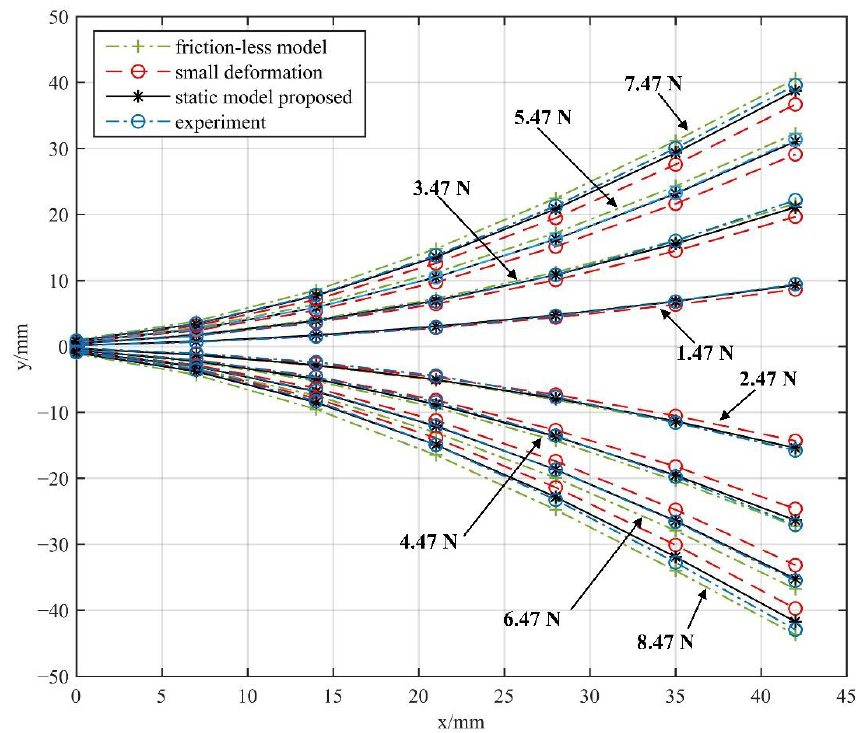
Figure 14. Deformation diagram of NCR under external loading test.